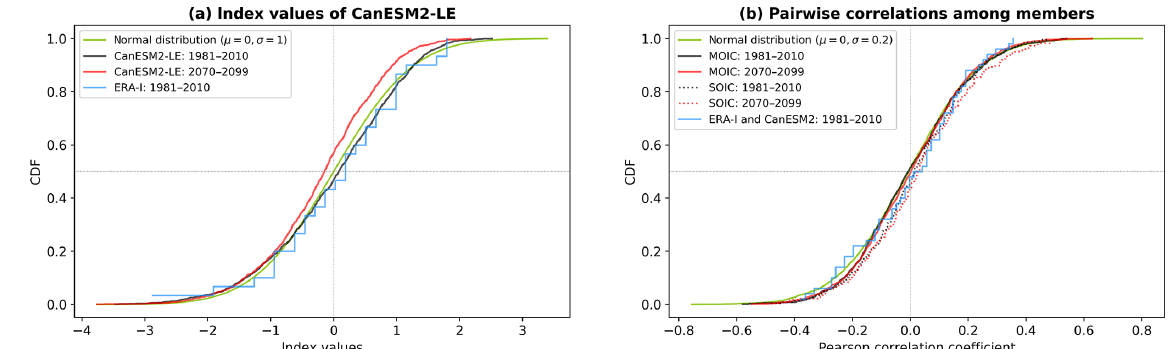
Figure 3. Cumulative density functions (CDFs) of NAO index values. (a) Distribution of all CanESM2-LE ( n = 50 × 30 per period) and ERA- I ( n = 30) NAO index values. (b) Pairwise correlations among member NAO index time series from the same ocean families (SOICs, dotted lines, n = 225), from different ocean families (MOICs, solid lines, n = 1000) and between ERA-I and all CanESM2 members ( n = 50). Black: 1981–2010 CanESM2-LE, red: 2070–2099 CanESM2-LE, blue: 1981–2010 ERA-I, green: normal distribution with µ = 0 and σ = 1 in panel (a) and σ = 0 . 2 in panel (b)